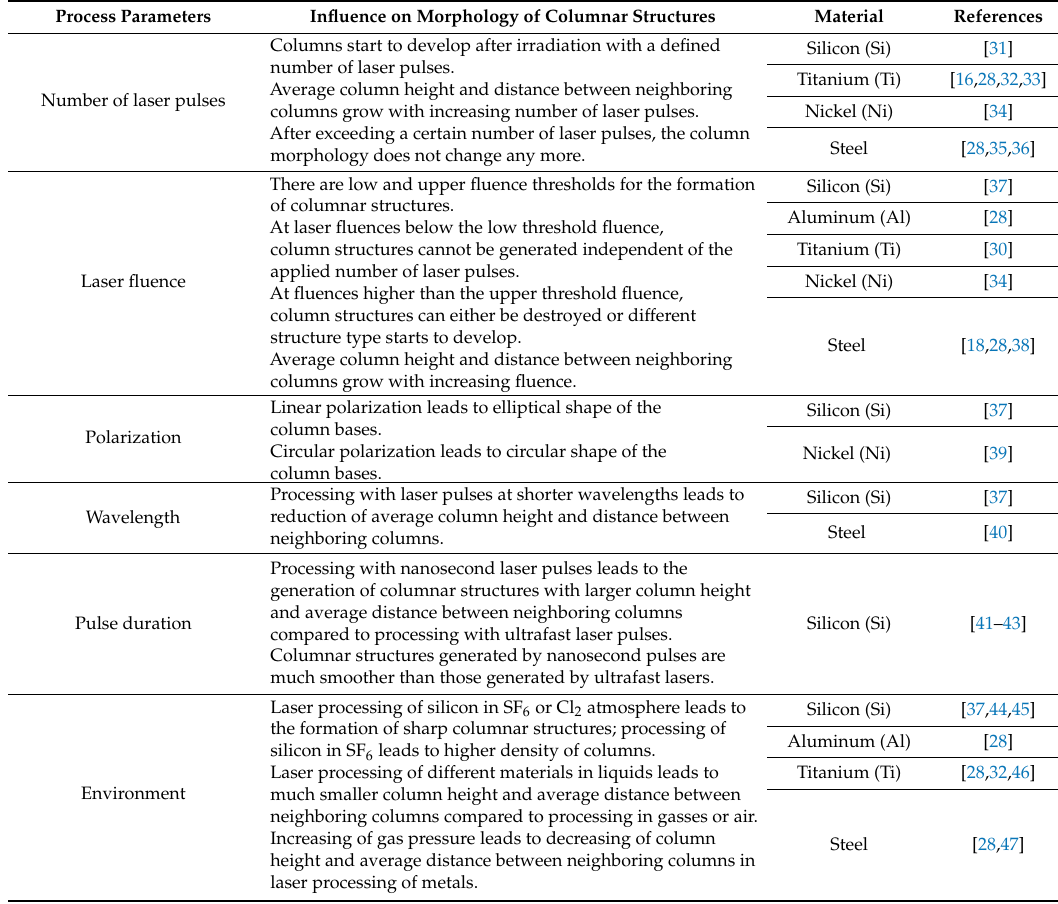
Table 1. Influence of process parameters on morphology of columnar